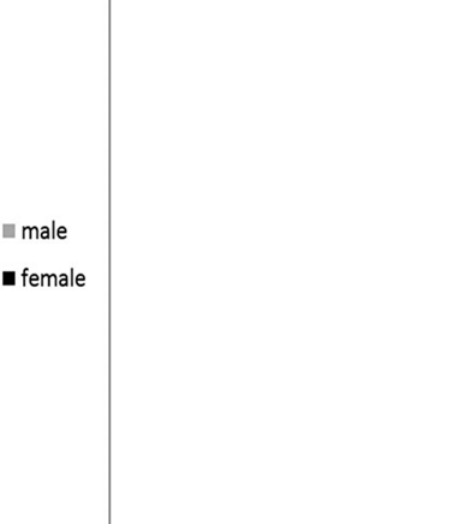
PLOS ONE | DOI:10.1371/journal.pone.0121451 March 23,